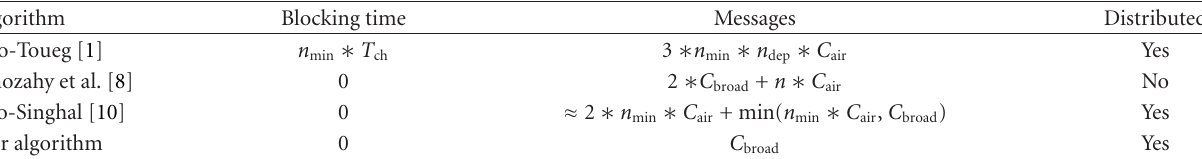
Algorithm 1: Nonblocking Algorithm. Table 1: System performance.